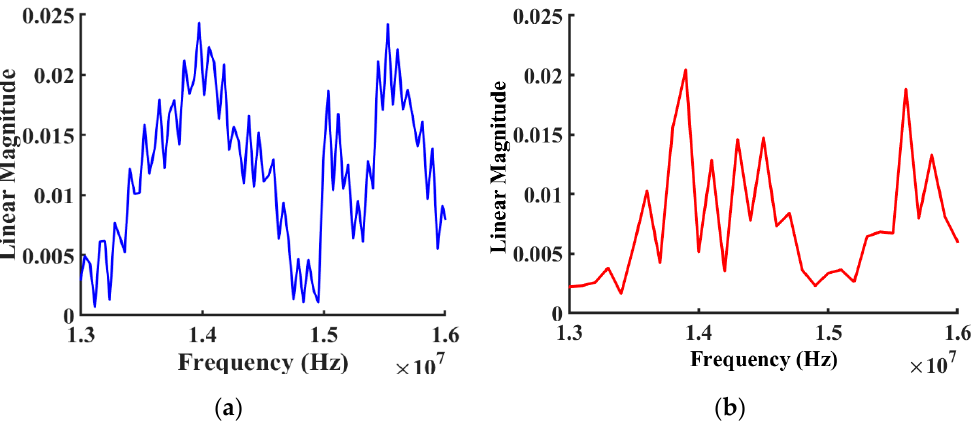
Figure 9. Comparison between simulated (Blue) and measured (Red) linear magnitude frequency response for the device (with Cr IDTs only) from 13 MHz to 16 MHz. ( a ) Simulated linear magnitude frequency response of the design. ( b ) Measured linear magnitude frequency response from the fabricated device.